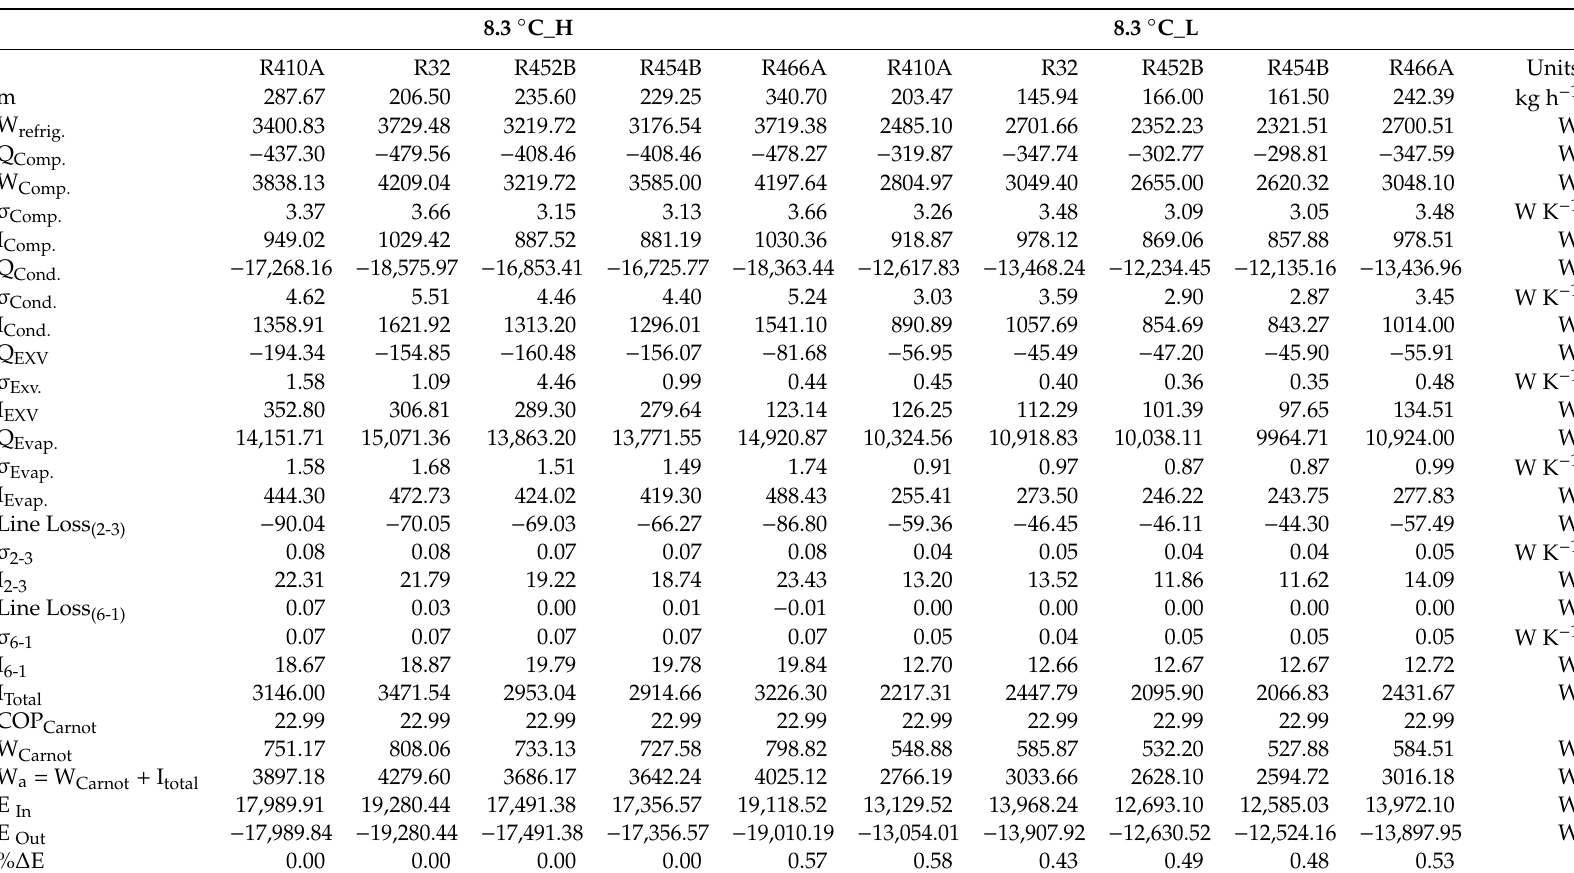
Table 5. Thermal and mechanical energy exchanges from the Department of Energy, Oak Ridge National Laboratory (DOE / ORNL) Heat Pump Design Model (HPDM) model and application of Equations (8)–(11), at 8.3 ◦ C ambient